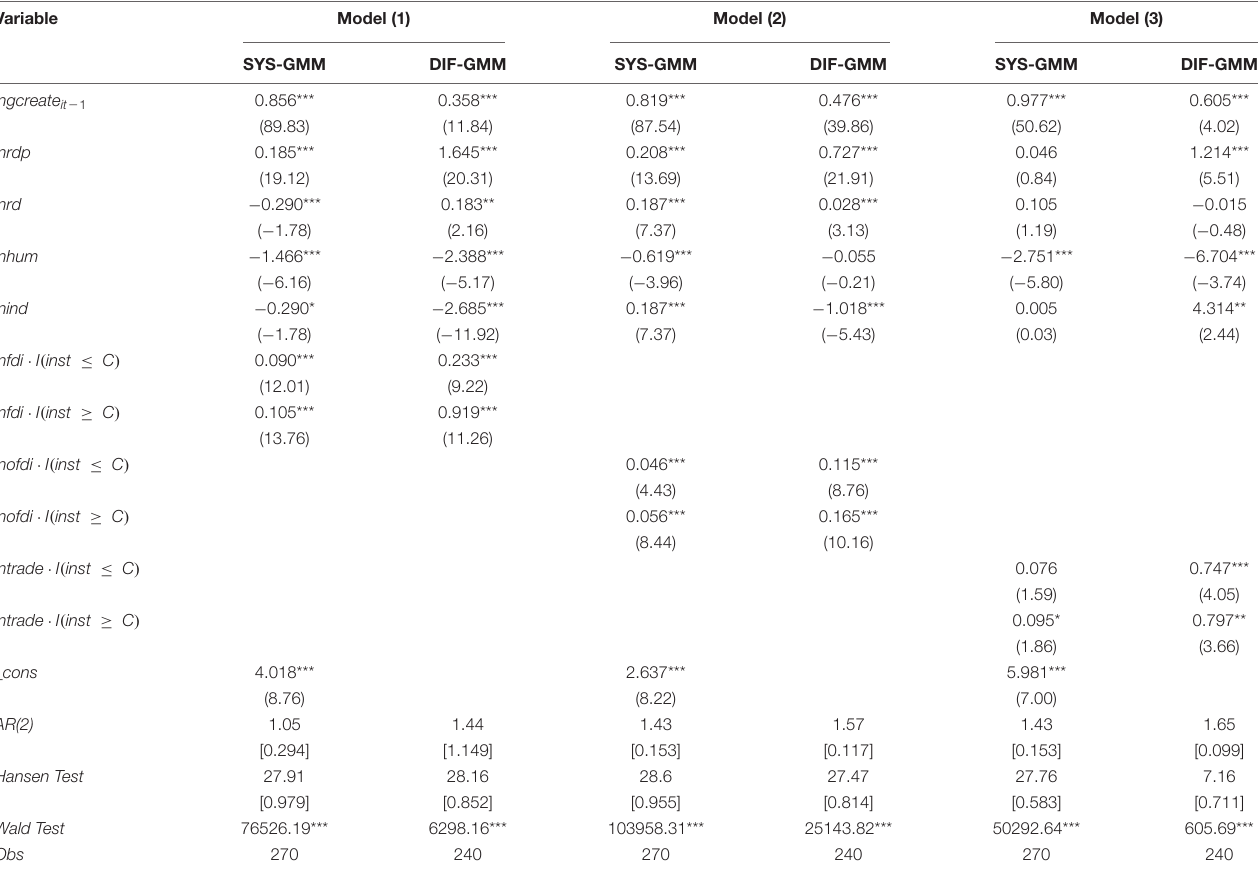
TABLE 7 | Dynamic threshold regression results.